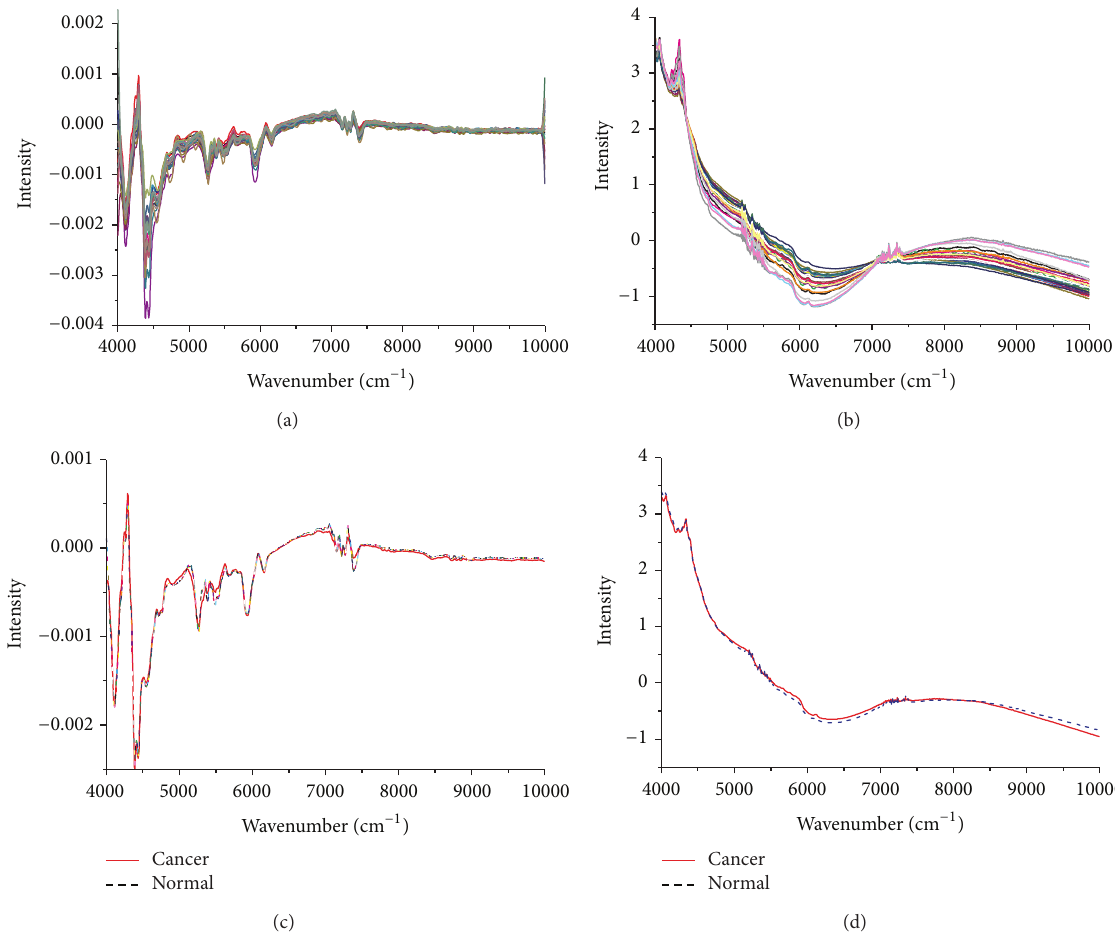
Figure 1: Preprocessed and mean spectra of cancerous and normal samples. (a) First derivative-based preprocessed spectra. (b) SNV- based preprocessed spectra. (c) Mean spectra corresponding to first derivative preprocessing. (d) Mean spectra corresponding to SNV